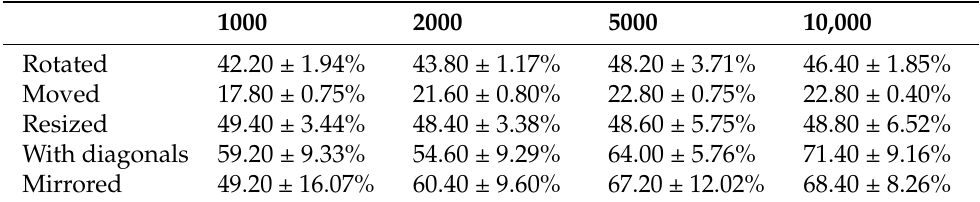
Table 5. The number of transformed objects: 2; Level of noise: 2.